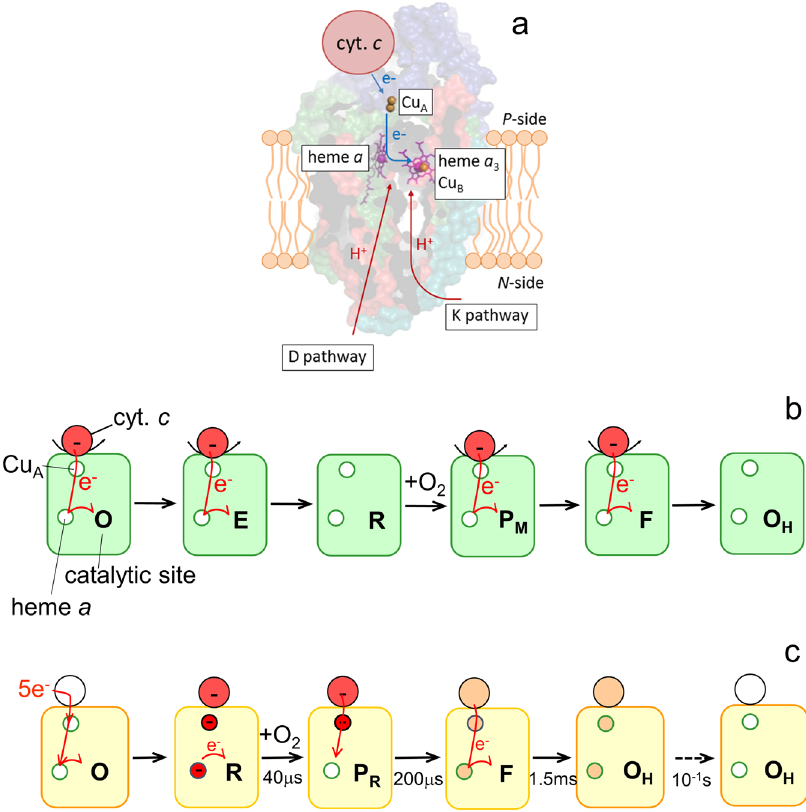
Figure 1. Experimental system and the studied reaction. ( a ) Cyt c O accommodates four redox-active centers: Cu A , heme a and the catalytic site composed of heme a 3 and Cu B , that upon reduction each bind one electron. The cyt. c -Cyt c O electrostatic complex accommodates in total five electrons in the reduced state. Two proton- uptake pathways, called D and K are indicated in the figure, but not discussed in the text. ( b ) Turnover of Cyt c O. One electron at a time is donated from cyt. c to Cyt c O. The initial state is the “relaxed” oxidized state. Consecutive addition of two electrons yields the two-electron reduced catalytic site which binds O 2 to form the peroxy state P M . Reduction of P M yields F, which is then reduced to form the “activated” oxidized state, O H . This state is then reduced by cyt. c . ( c ) Reaction studied in this work. The oxidized cyt. c -Cyt c O complex is reduced by 5 electrons. Upon initiation of the reaction (with a laser flash, not shown), O 2 binds to the catalytic site and an electron is transferred from heme a to the catalytic site to form the peroxy state, P R . This step is followed in time by formation of the ferryl state, F, which occurs over the same time scale as electron equilibration among Cu A /cyt. c and heme a . Electron transfer from this equilibrium to the catalytic site leads to formation of state O H . Over a longer time scale of ~0.1 s an electron equilibrates between the Cyt c O molecules via the bound cyt. c to eventually yield oxidized Cyt c O. Note that proton-transfer reactions are not indicated in the